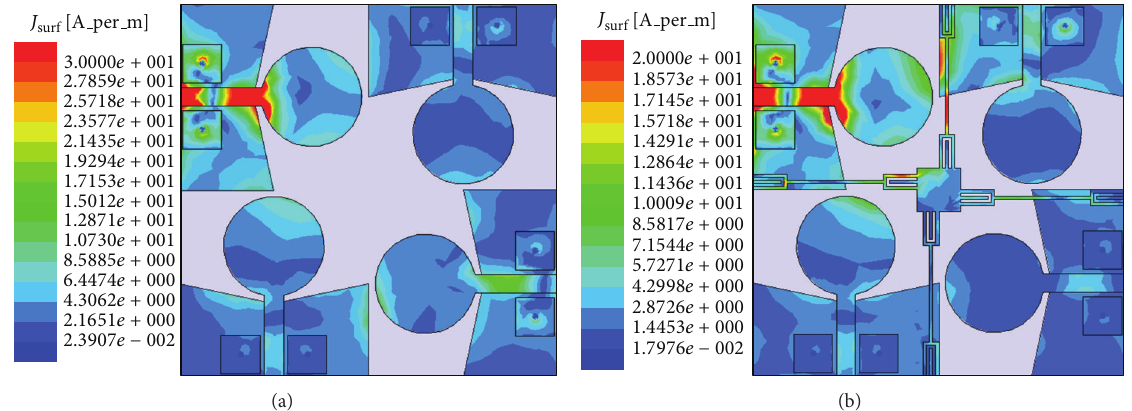
Figure 14: Surface current distribution at 6.7 GHz on (a) initial MIMO antenna and (b) final MIMO antenna.